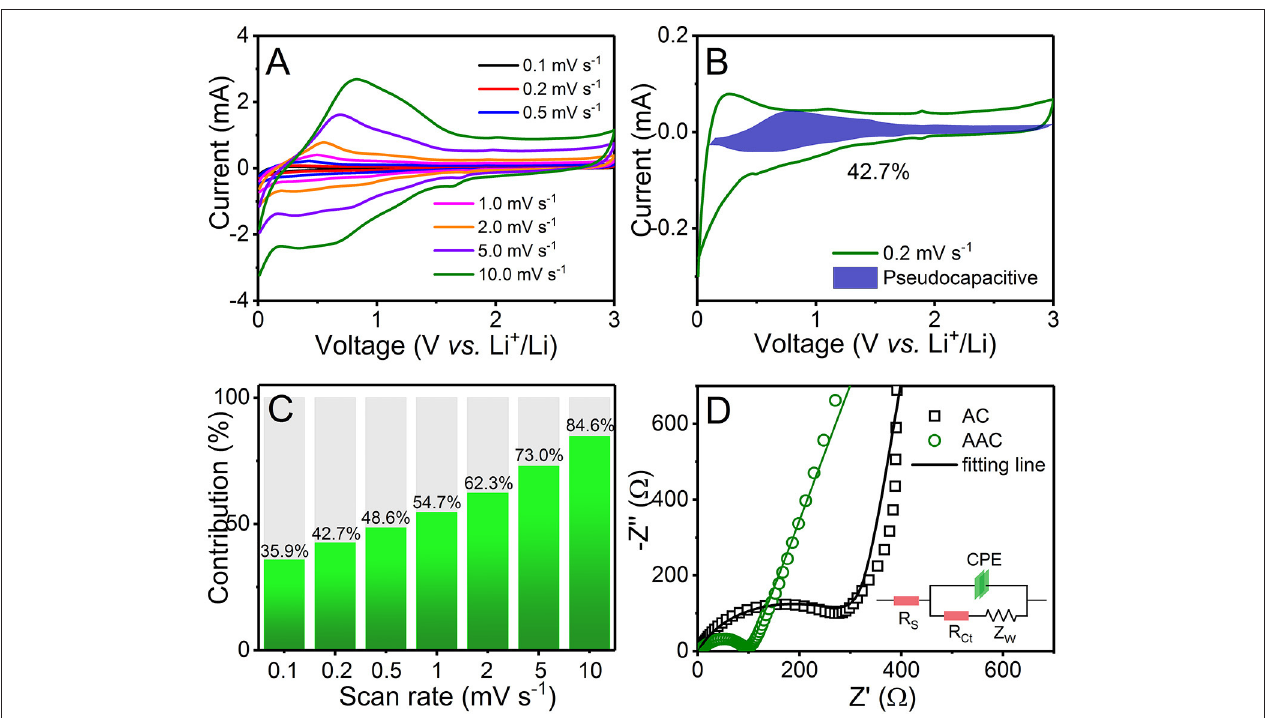
FIGURE 5 | (A) CV curves measured between 0.01 and 3.0V at different sweep rate from 0.1 to 10.0mV s − 1 ; (B) CV curve with a blue closed area representing pseudocapacitance at a sweep rate of 0.2mV s − 1 ; (C) bar chart of pseudocapacitive contribution at corresponding sweep rate; (D) electrochemical impedance spectra in form of Nyquist plots of AAC and AC before cycling with equivalent circuit diagram as the